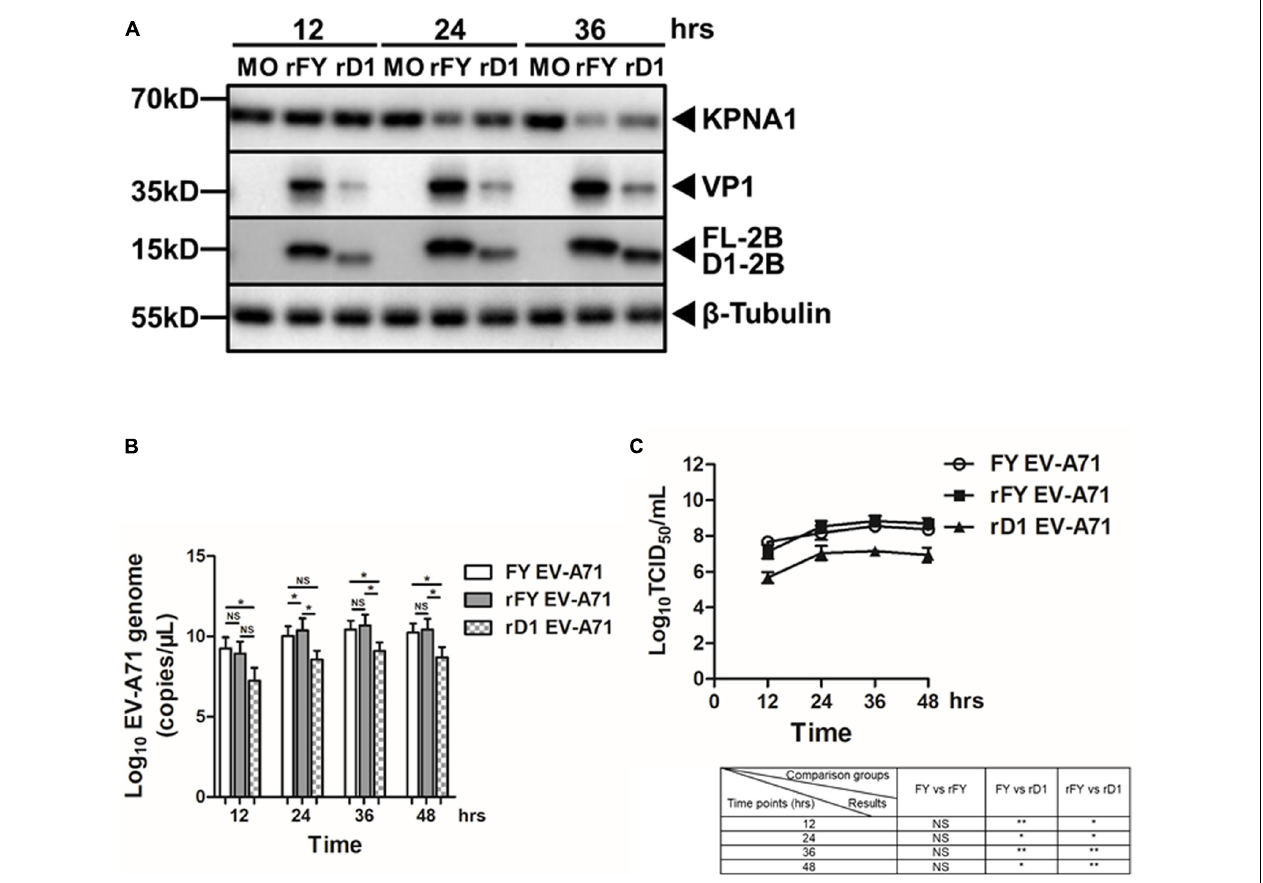
FIGURE 8 | Decreased KPNA1 degradation and viral replication in rD1 EV-A71-infected cells. (A) Decreased degradation of KPNA1. HeLa cells were infected with rFY or rD1 EV-A71 at an MOI of 1. The cell lysates were prepared at indicated time points p.i. for western blot analyses with antibodies for KPNA1, VP1, 2B, or β -Tubulin. (B,C) Effect of 2B deficient of the H1 domain on viral replication. HeLa cells were infected with either rFY or rD1 EV-A71. Total RNA was prepared at various time points p.i. for real-time RT-PCR to measure viral RNA copy numbers (B) ; Cell culture medium was sampled at various time points p.i. for infectious virus titration (C) . Error bars represent standard deviations of the results of three repeated experiments. NS, no significance; * P < 0.05; and ** P <